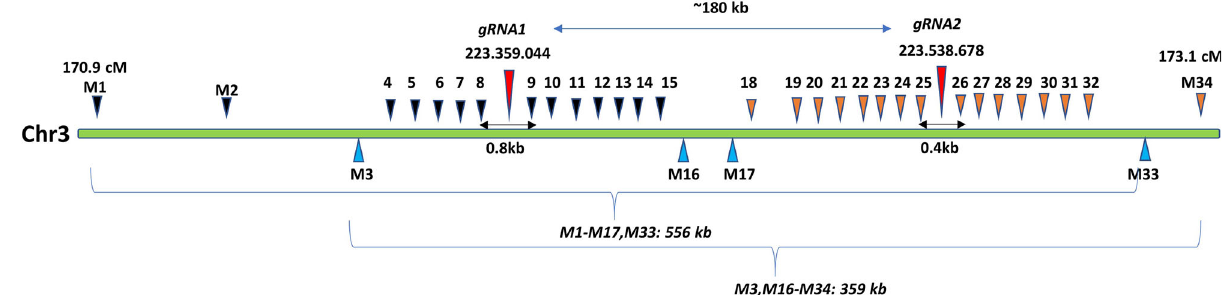
Fig. 1 Schematic diagram of the two target regions (gRNA1 and gRNA2) and the locations of the polymorphic SNP markers (M1-M34) used in the genotyping assays. Schematic SNP marker positions are shown as black, brown, and blue triangles. The blue triangles represent SNP markers that were shared in the two different genome editing experiments. The physical genome coordinates of the gRNA target sites are based on the B73 genome reference public assembly: Zm-B73-REFERENCE-NAM-5.0. (https://www.maizegdb.org) 11 . The physical position of each SNP marker can be found in Supplementary Data